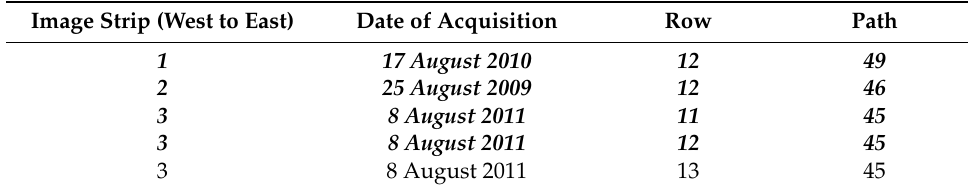
Table 4. Landsat 5 data evaluated in this research. Text for images containing training and validation sites have been bolded and italicized. This table is adapted from